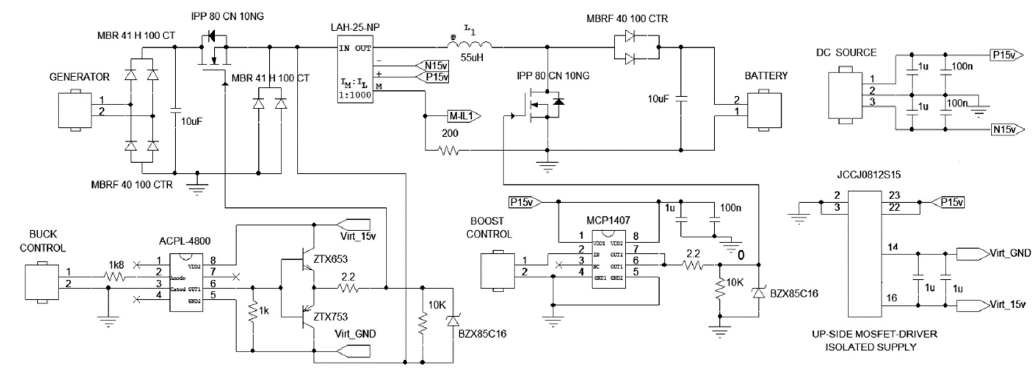
Figure 17. HBB converter power stage.